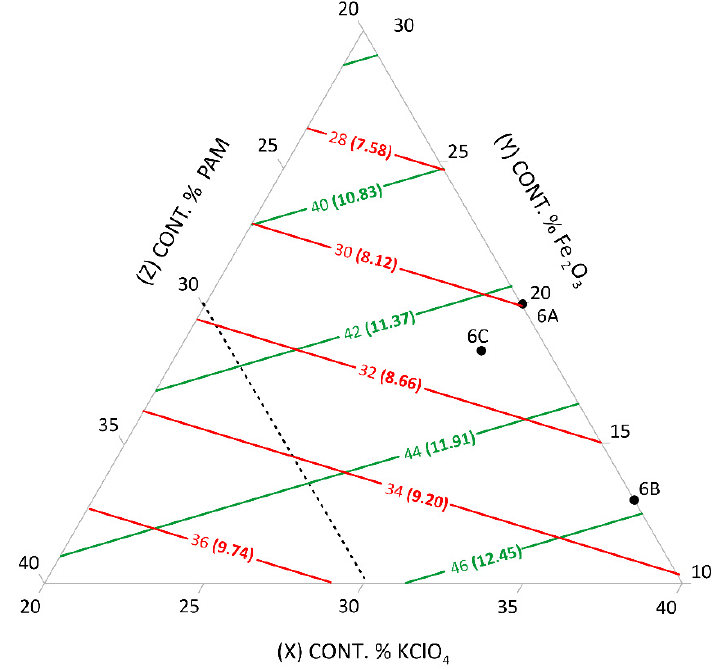
Figure 6. Relationship between costs of the composition (USD/kg): red line—1981, green line—2021; and the content of pyrotechnic composition components (%). Sides of the triangle, with fixed sulphur content S = 30%.